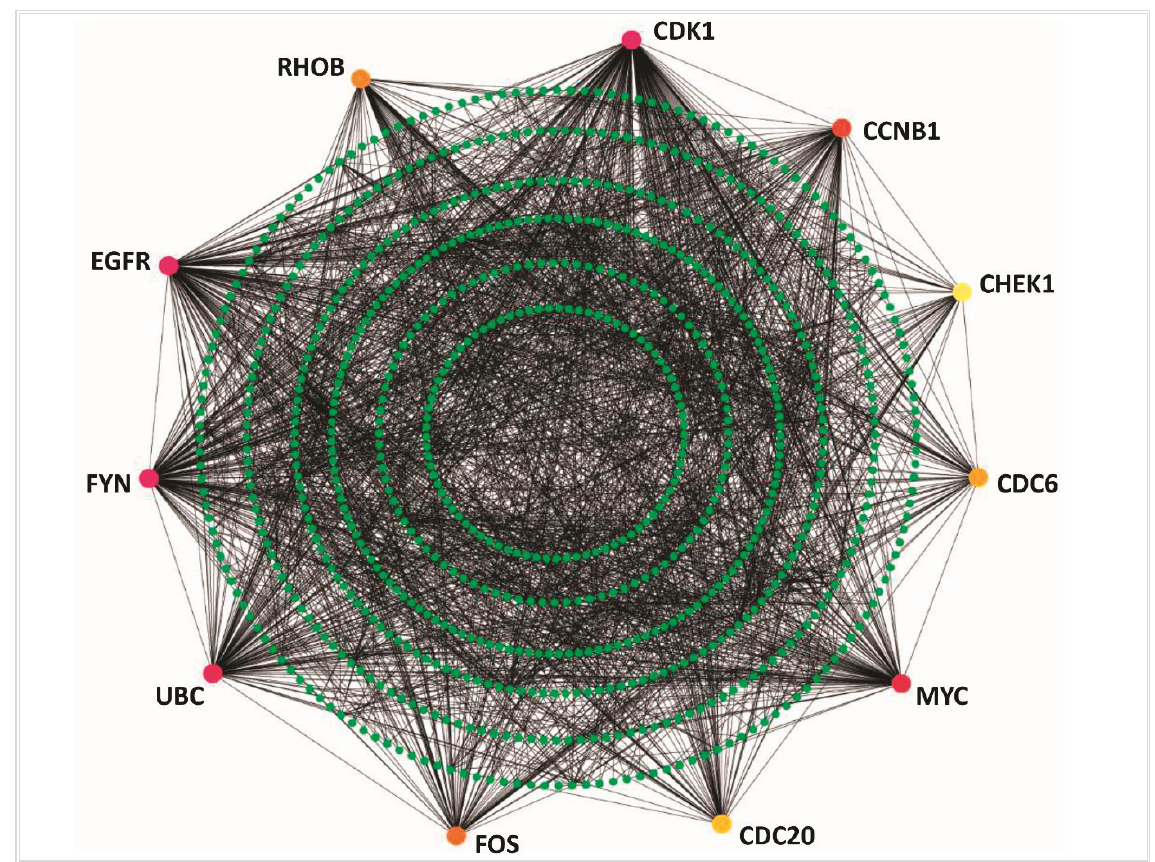
Figure 3. NSCLC-specific protein – protein interaction network. The redder color represents the higher degree measured by CytoHubba. The hub-DEGs are represented only with the different colors in the PPI. Green nodes represent the associated proteins. Table 1. The physicochemical properties of the reported hub